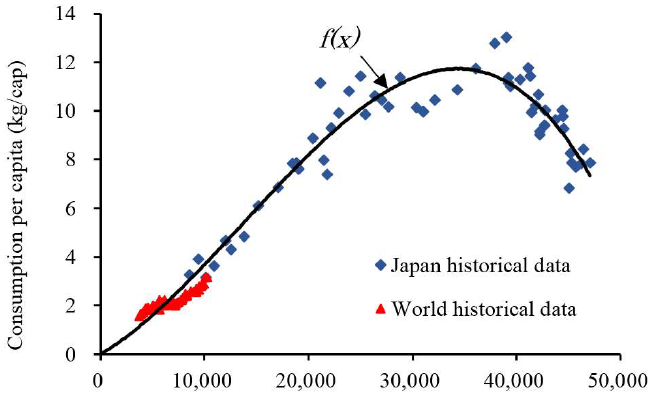
Figure 10. Approximation result of top-down model for copper.